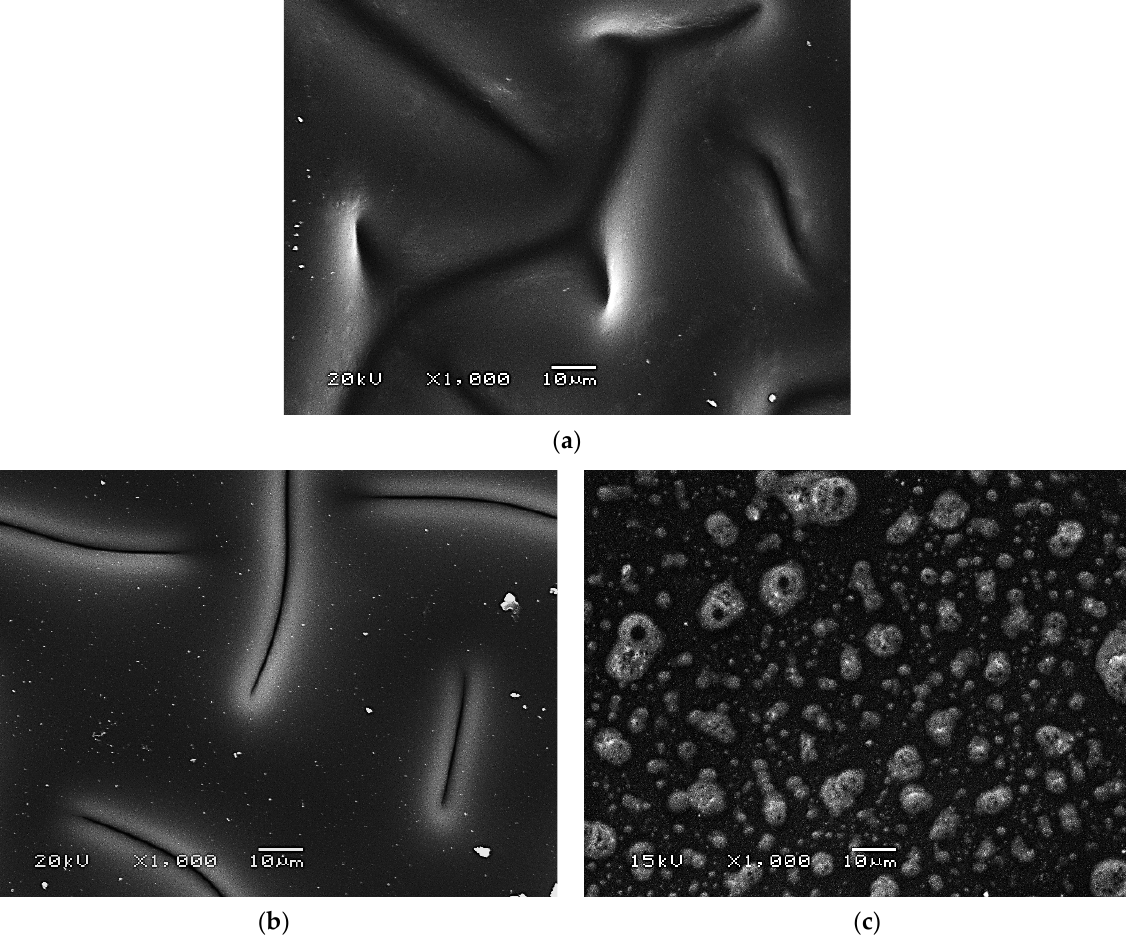
Figure 9. SEM images of unmodified hydrogel ( a ) and hydrogels containing protein particles: sample 1.0_protein ( b ) and sample 3.0_protein ( c ).